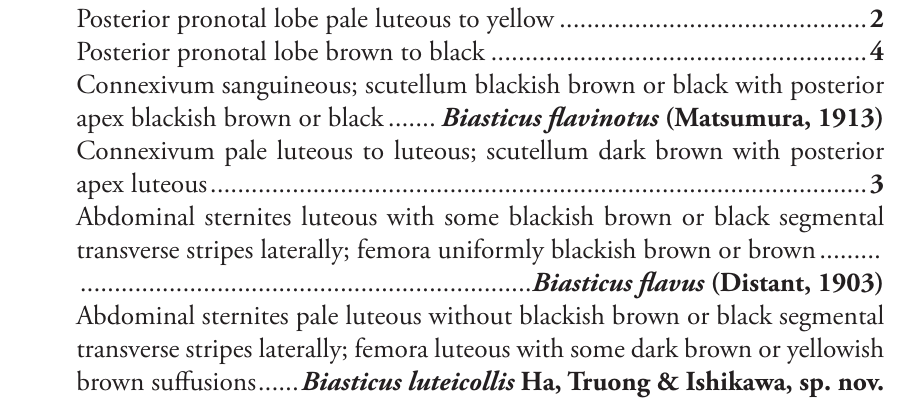
Connexivum pale luteous to luteous; scutellum dark brown with posterior Abdominal sternites luteous with some blackish brown or black segmental transverse stripes laterally; femora uniformly blackish brown or brown ......... Abdominal sternites pale luteous without blackish brown or black segmental transverse stripes laterally; femora luteous with some dark brown or